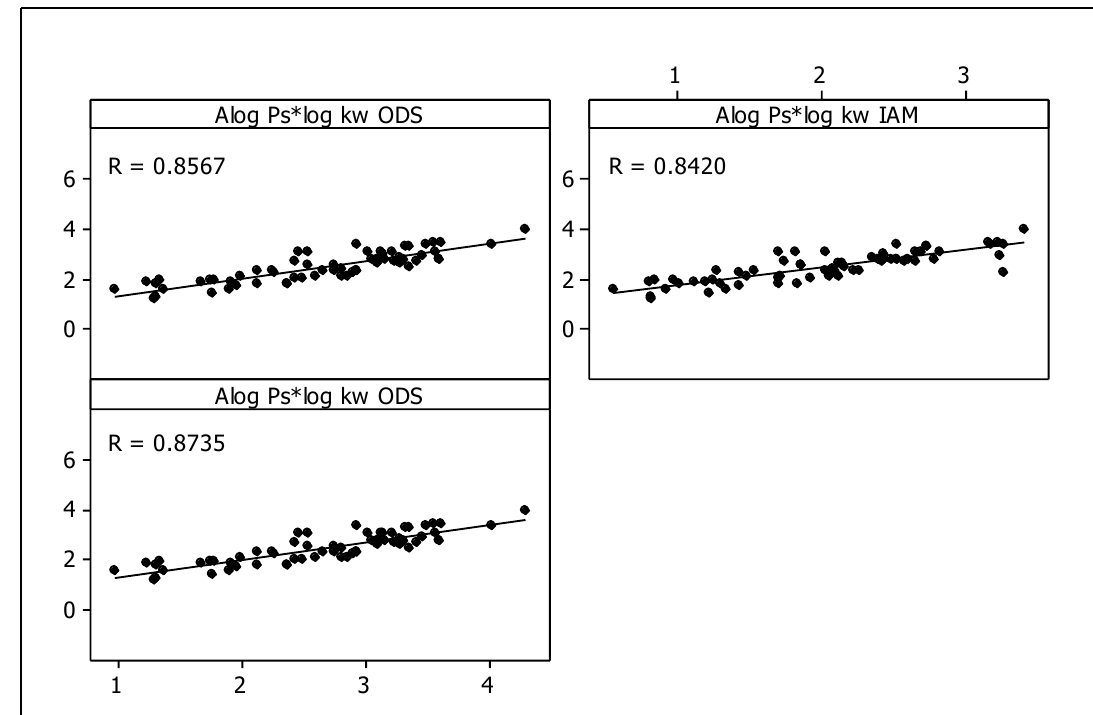
Figure 8. Alog P s vs. log k w relationships obtained for ODS, IAM and Cholester